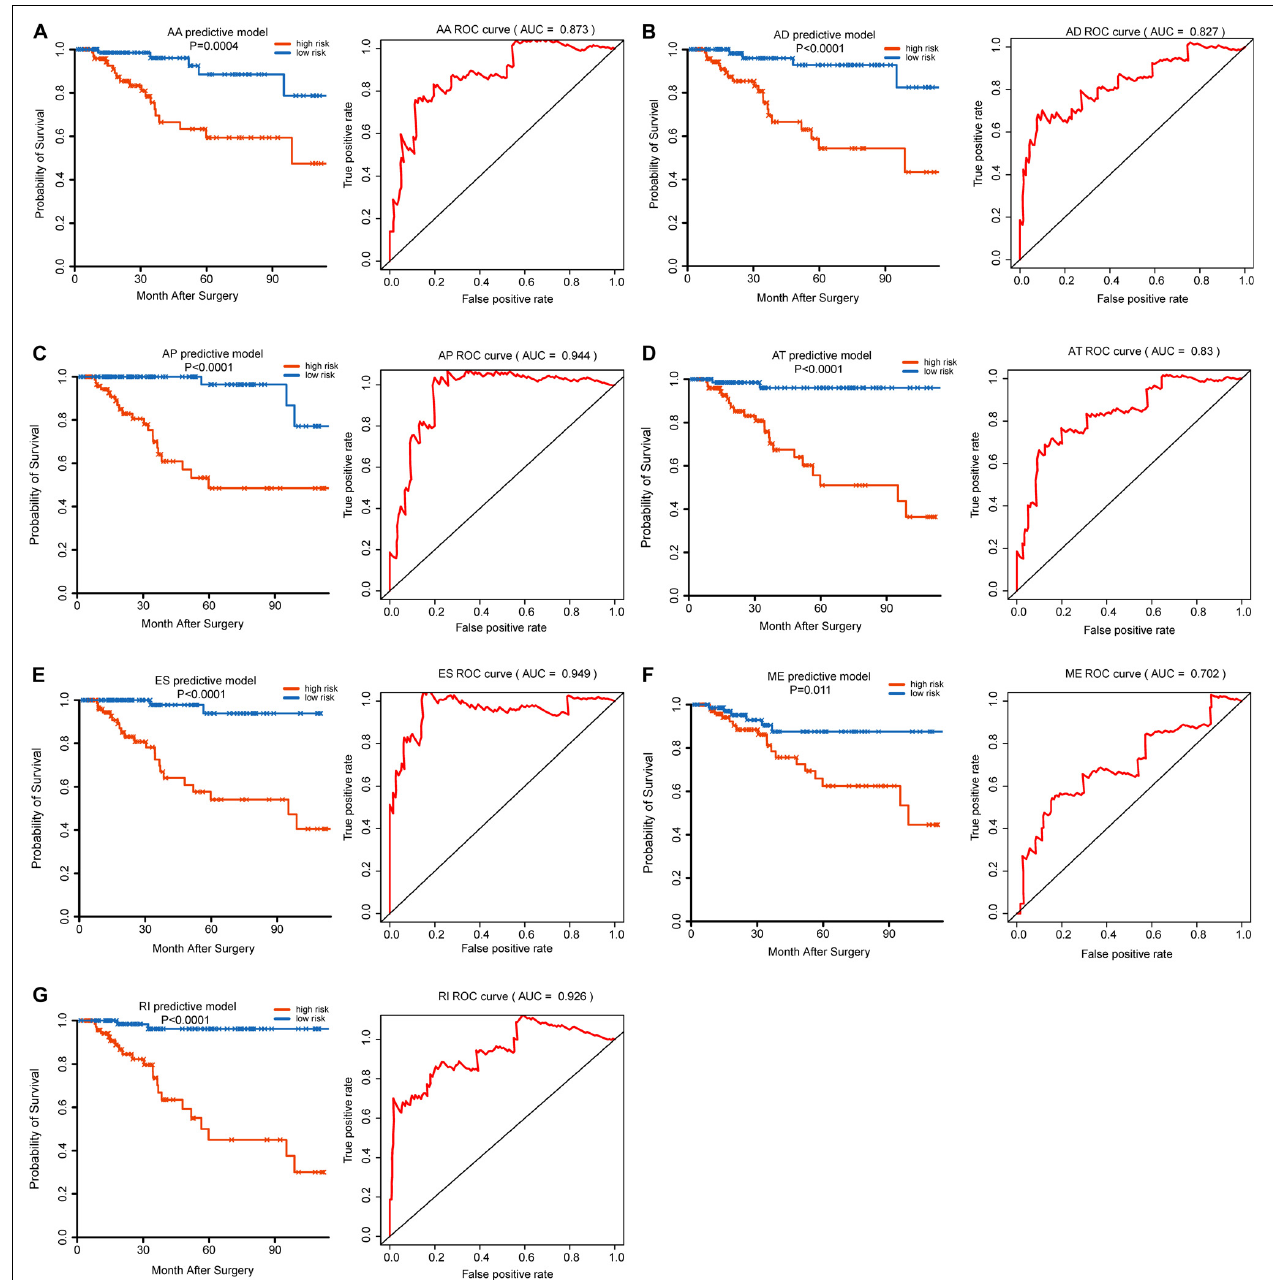
FIGURE 5 | Kaplan–Meier (K–M) plot and time-dependent ROC curves for the multivariate prognostic AS models in TNBC. Kaplan–Meier curves of the multivariate prognostic models were generated for (A) AA, (B) AD, (C) AP, (D) AT, (E) ES, (F) ME, and (G) RI patterns of AS, respectively. In K–M plot, red line represents high-risk subgroup while blue line represents low-risk subgroup. ROC curves with AUC for 3-year survival were constructed with each type of AS event in TNBC. AUC value of the ROC curve of > 0.7 was observed in each type of AS in